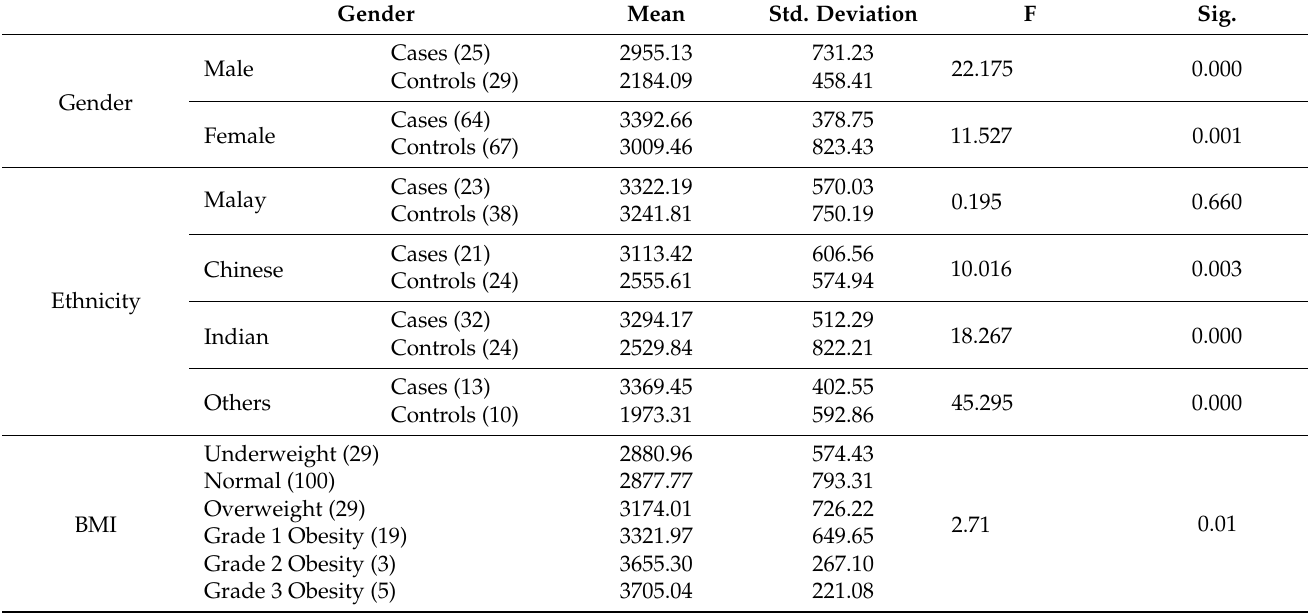
Table 1. ANOVA test results of serum leptin (pg/mL) levels between control and cases based on gender, ethnicity, and